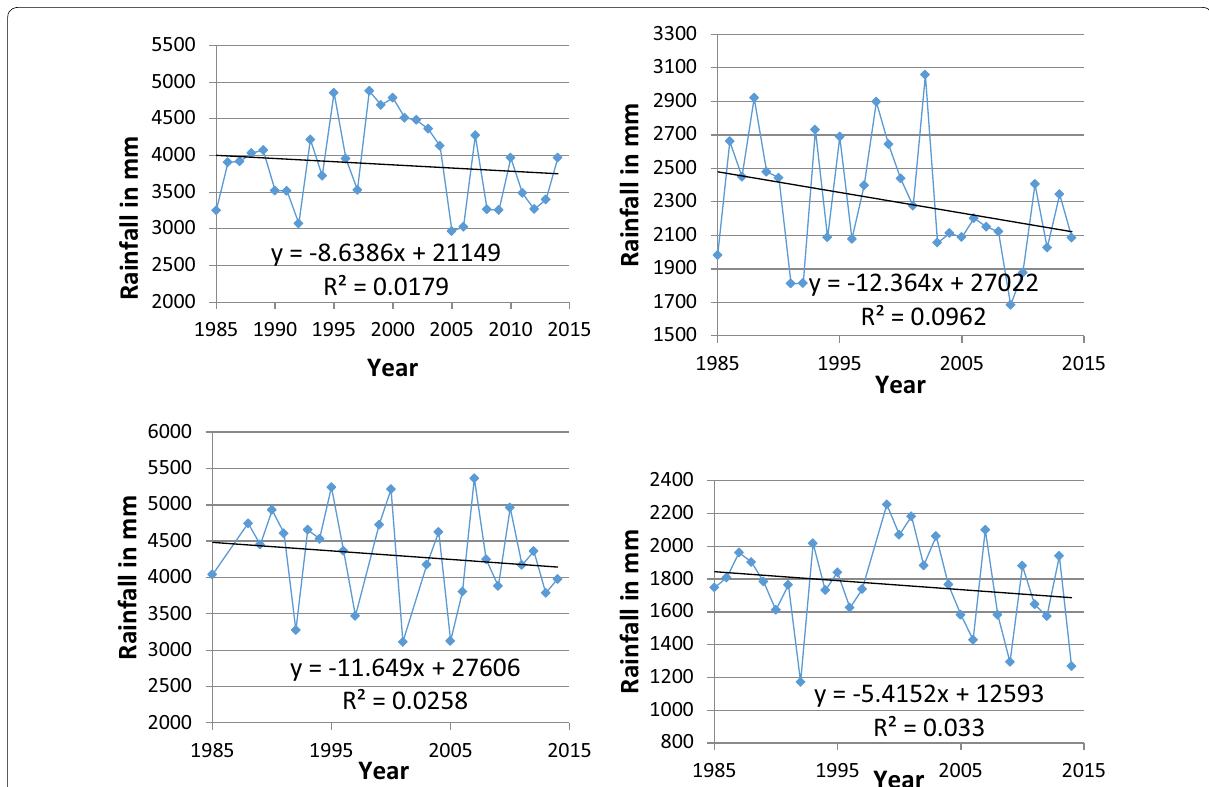
Fig. 17 30 years of total annual rainfall (1985–2014) trend in the study area (Pokhara airport, Khairinitar, Lamachaur, and Damauli)